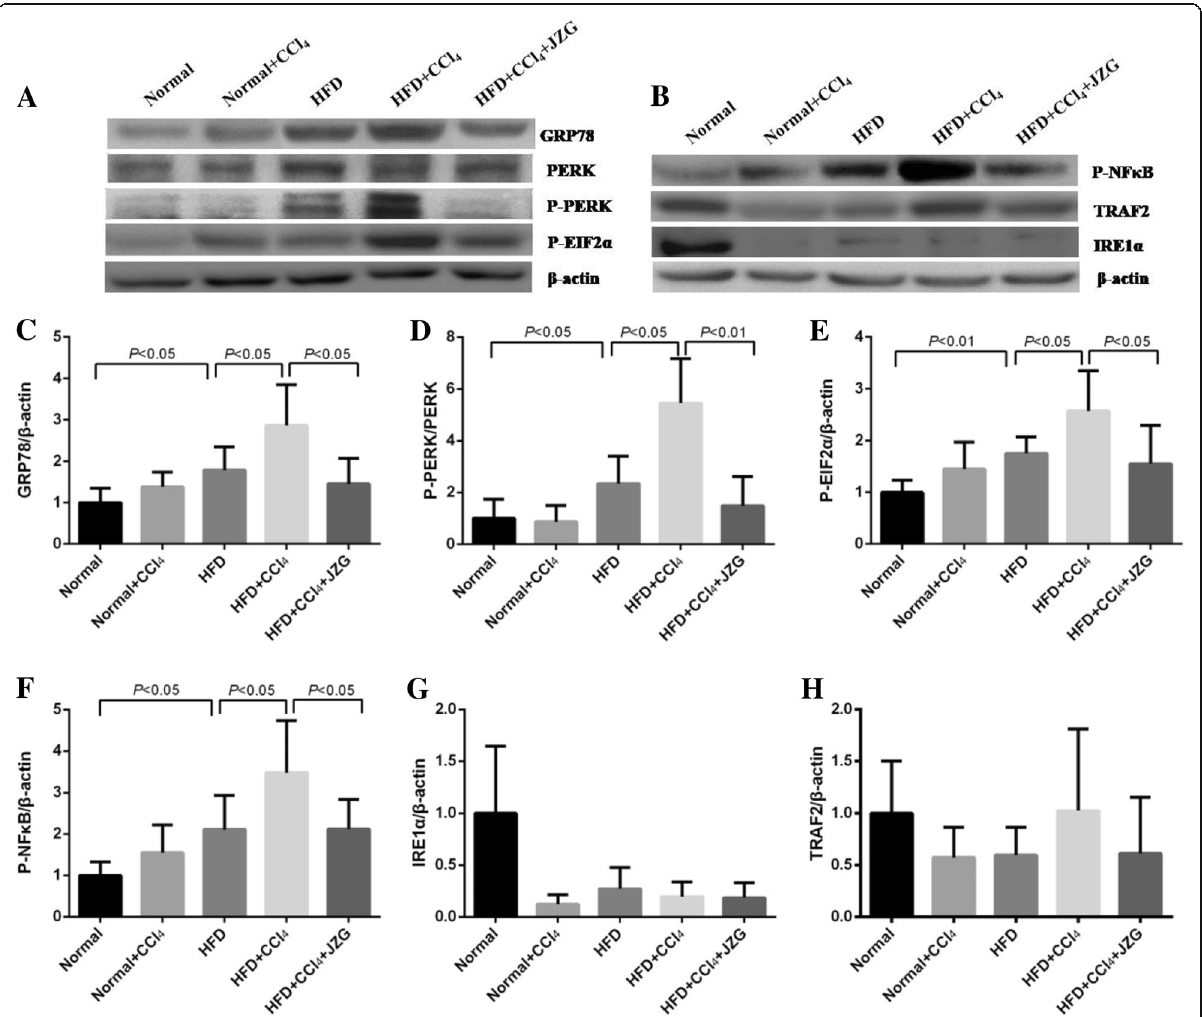
Fig. 7 Effect of JZG on protein expression of ERS related genes: a - b Representative western blot results of GRP78, PERK, P-PERK, P-EIF2 α , P-NF κ B, IRE α , and TRAF2 in rat liver tissues, c - h Densitometric analysis of GRP78, PERK, P-PERK, P-EIF2 α , P-NF κ B, IRE α , and TRAF2, values were normalized to that of β -actin. The values represent the mean ± SD. ( N = 6 per